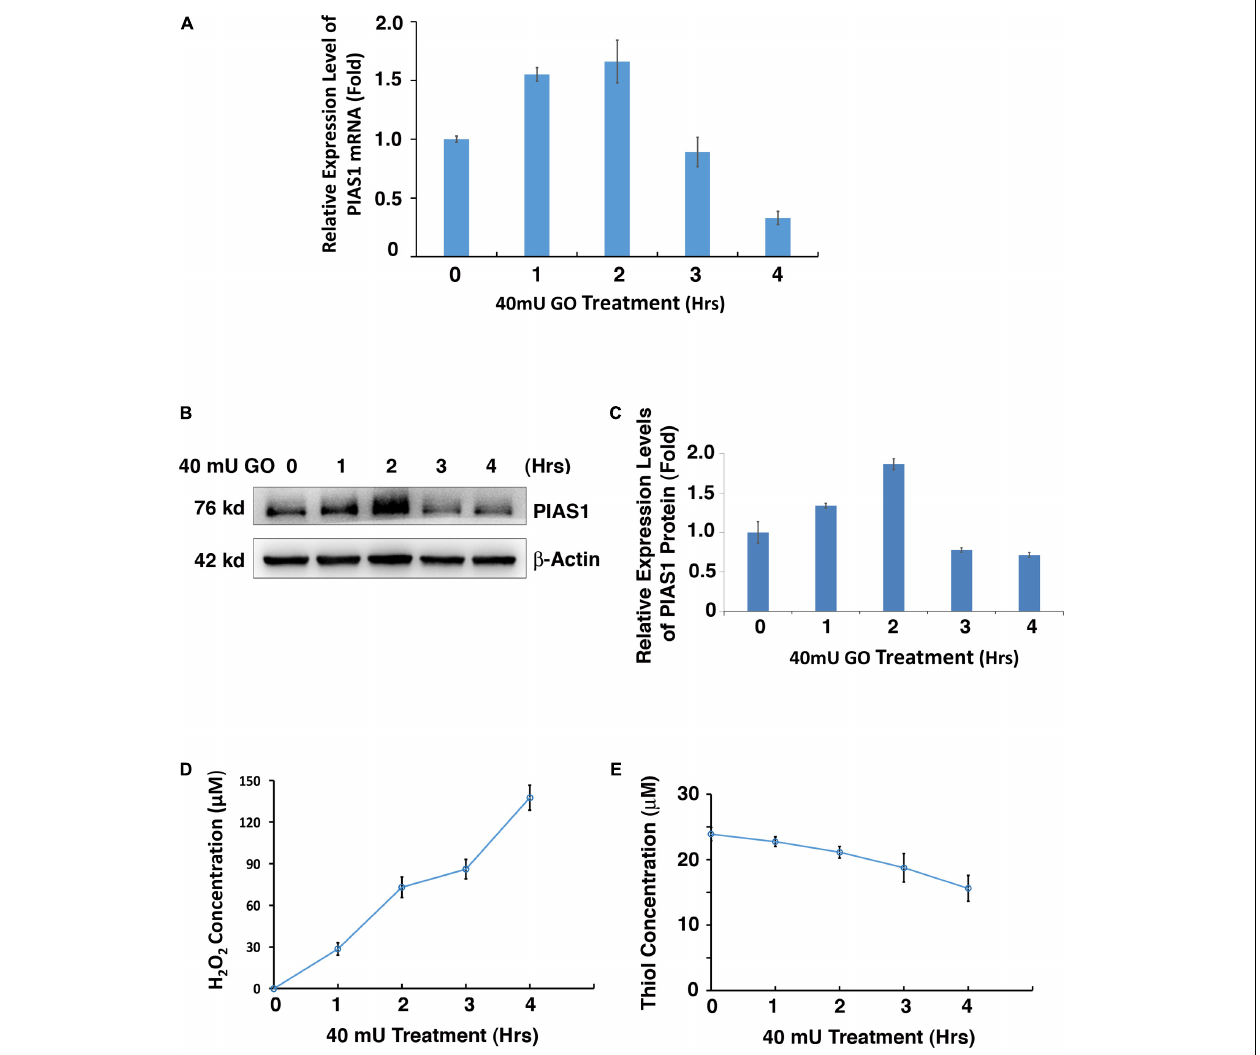
FIGURE 1 | Oxidative stress regulates PIAS1 expression in lens epithelial cells. (A) The expression of mRNA levels of PIAS1 under 40 mU GO treatment from 0 to 4 h was determined by real-time PCR. Ct values of each sample were normalized with the Ct value of β -actin. (B) Western blot analysis of PIAS1 protein level under 40 mU GO treatment from 0 to 4 h. The β -actin was used as a loading control. (C) Quantification of the Western blot results in panel (A) . (D) Dynamic H 2 O 2 concentration generated from 40 mU GO in α TN4-1 cells from 0 to 4 h. (E) Dynamic changes of free thiol content upon 40 mU GO treatment in α TN4-1 cells from 0 to 4 h. All experiments were repeated three times. Error bar represents standard deviation, N =